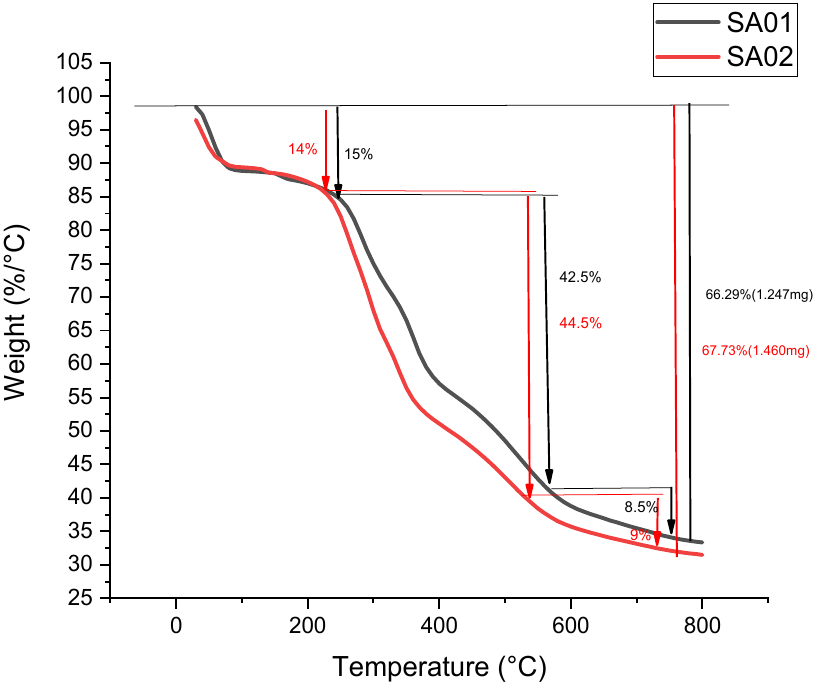
Figure 4. Thermogram of PEEK; SA-01 and SA-02.